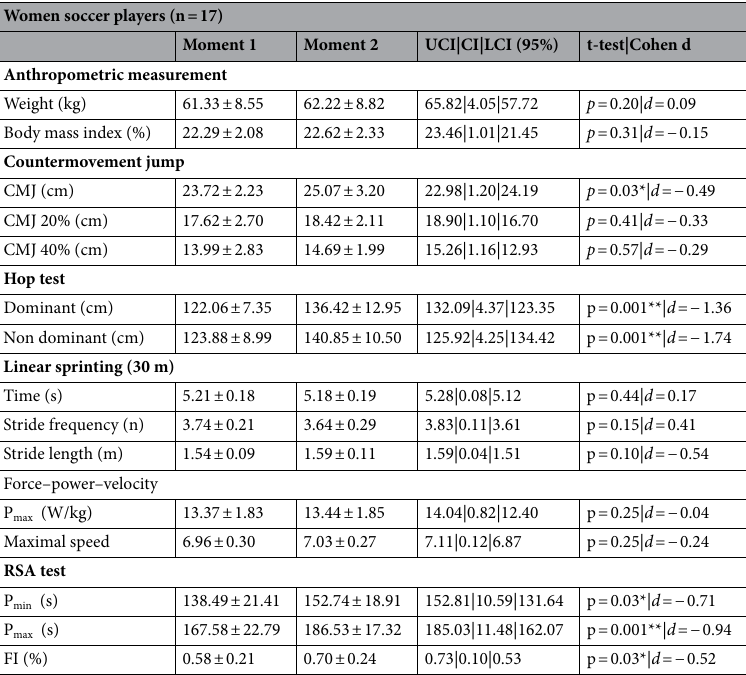
Table 1. Anthropometric measurement and fitness variables at the two moments of assessment (mean ± SD). UCI upper confidence interval, CI confidence interval, LCI lower confidence interval, CMJ